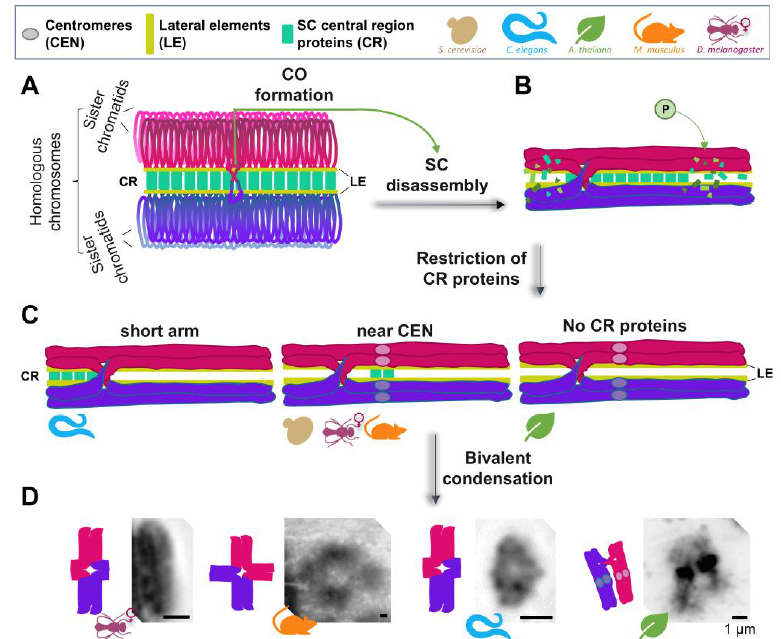
Figure 1. Meiotic bivalent remodeling in different model organisms. ( A ) A pair of fully synapsed homologous chromosomes (in magenta and purple) is shown, with only the lateral element (LE) and central region (CR) proteins of the synaptonemal complex (SC) being highlighted for simplicity. ( B ) Upon interhomolog crossover (CO) formation, different types of regulation may trigger SC disas- sembly, starting in late pachytene (shown is the phosphorylation of SC proteins). ( C ) SC